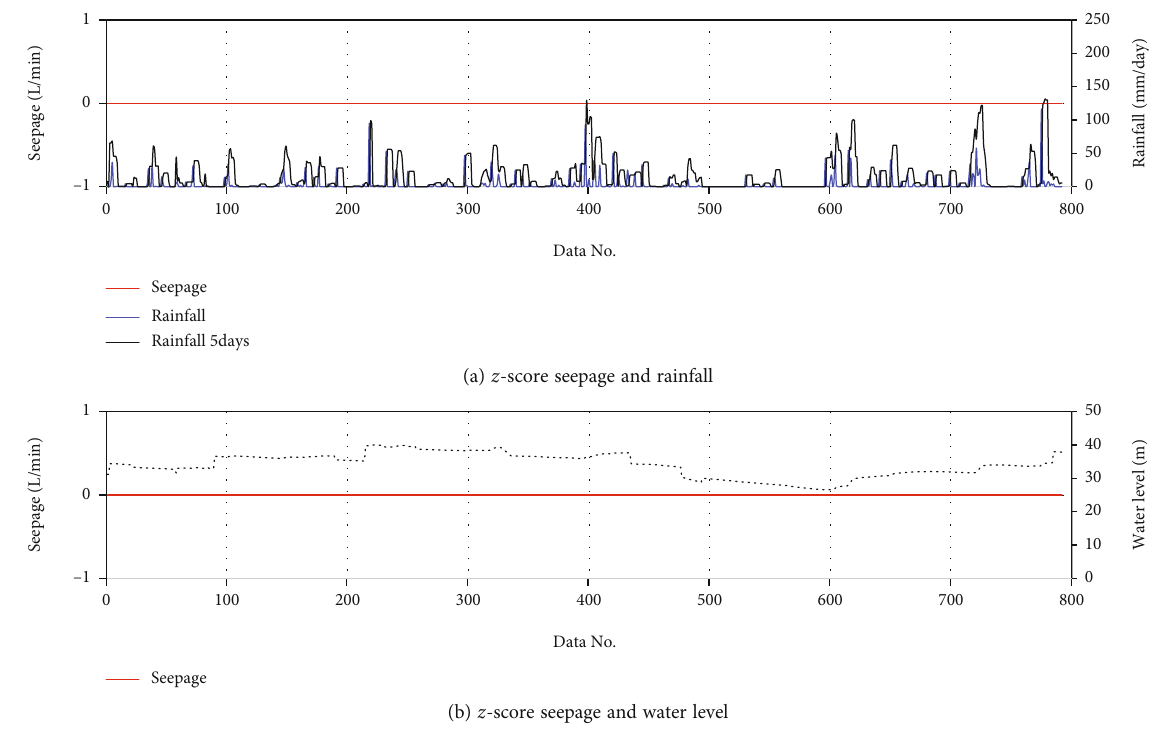
Figure 8: Time histories for no